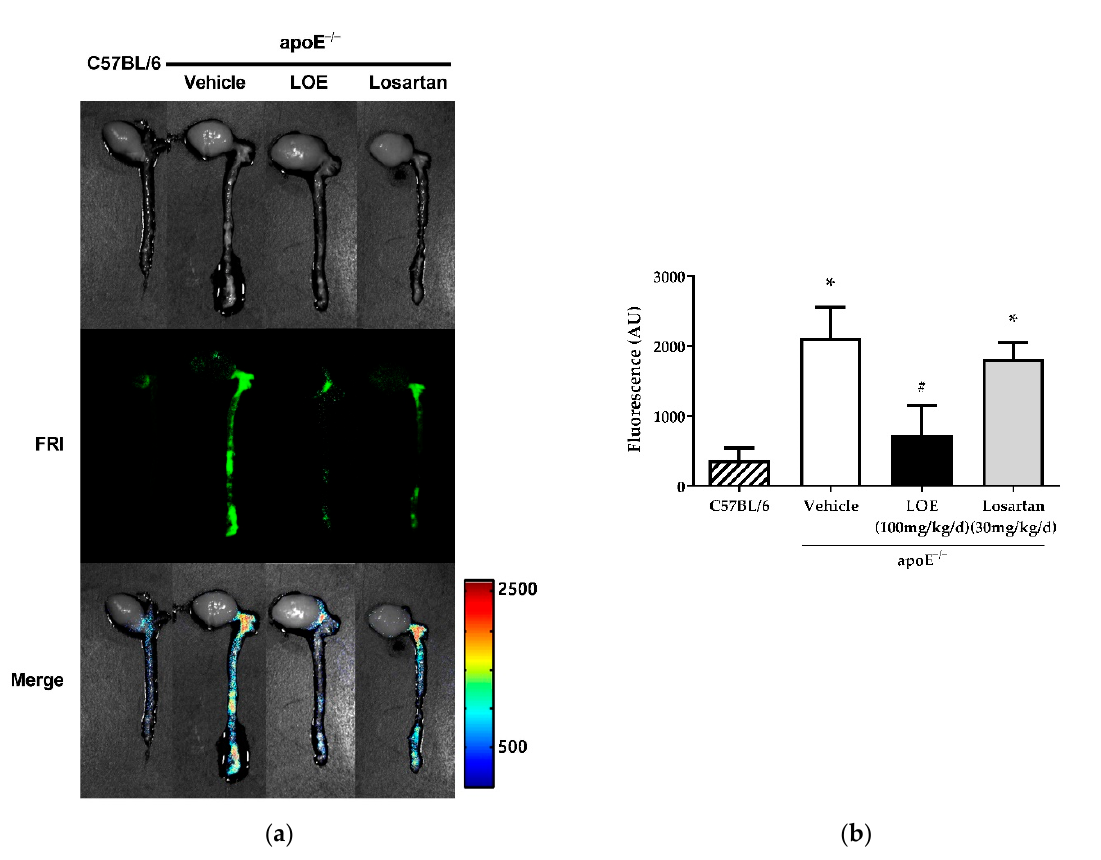
Figure 4. Effect of LOE and losartan treatments on plaque inflammation in the aortas of apoE − / − mice. LOE treatment significantly reduced the degree of plaque inflammation in western diet-fed apoE − / − mice, whereas losartan treatment did not. In vivo imaging of atherosclerotic plaque inflammation was assessed by fluorescence reflectance imaging (FRI) using AP-HGC-Cy5.5 nanoparticles. The extent of plaque inflammation was measured with an IVIS-200 FRI system. ( a ) Middle: FRI; bottom: merged images. ( b ) Corresponding cumulative data. The results are expressed as mean ± SEM (n = 4–6). * p < 0.05 versus the C57BL/6 group and # p < 0.05 versus the apoE − / − vehicle group.